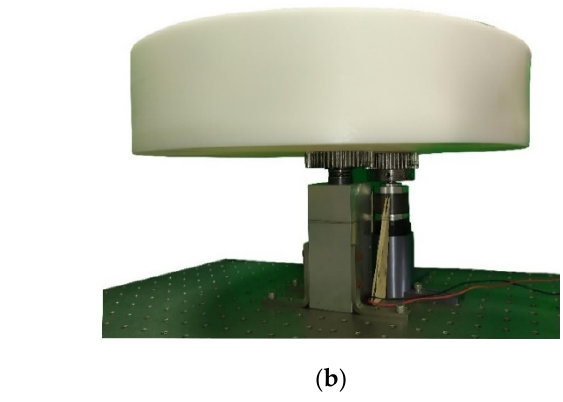
Figure 8. Experimental setup: ( a ) top view, ( b ) side view.